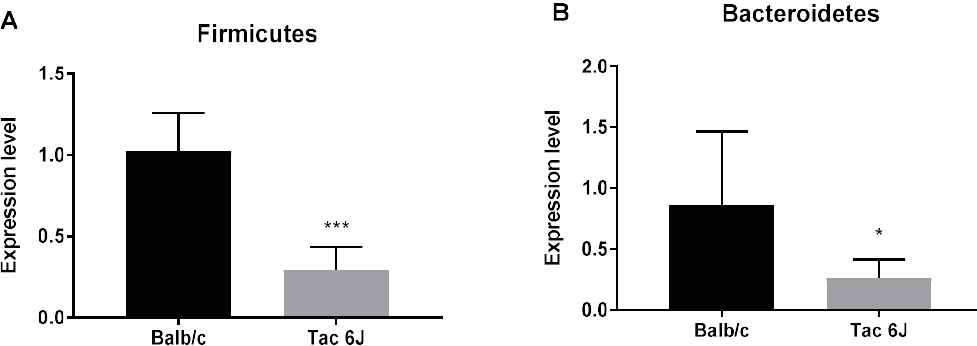
Figure 4. Differences in microbiota composition of different breeds of mice. Initial microbiota composition of BALB/cAnNTac (Balb/c) and C57BL/6JBomTac (Tac 6J) mice was measured through quantitative real-time PCR analysis. The expression level of both graphs was compared with the Universal bacteria primer (U1). The number of samples analyzed was 5. ( A ) The expression levels of Firmicutes of Balb/c and Tac 6J; ( B ) The expression levels of Bacteroidetes of the Balb/c and Tac 6J groups. Data are presented as the means ± SD analyzed by Fisher’s LSD test. Significance is indicated when * p < 0.05 and *** p < 0.001.